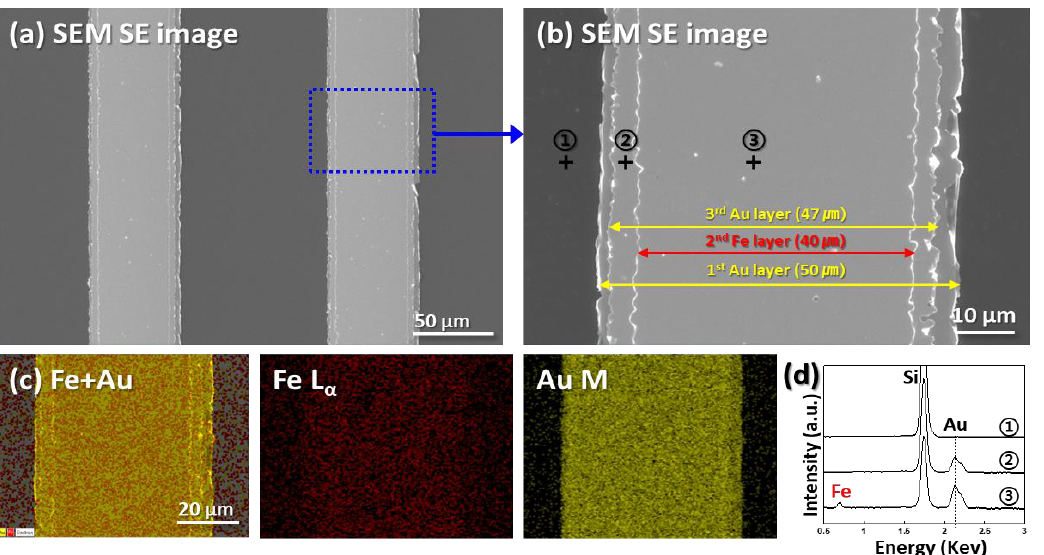
Figure 4. Cross-sectional SEM images of vertical Si groove arrays produced by magnetically guided MACE for etching durations of ( a ) 3 h and ( b ) 5 h.